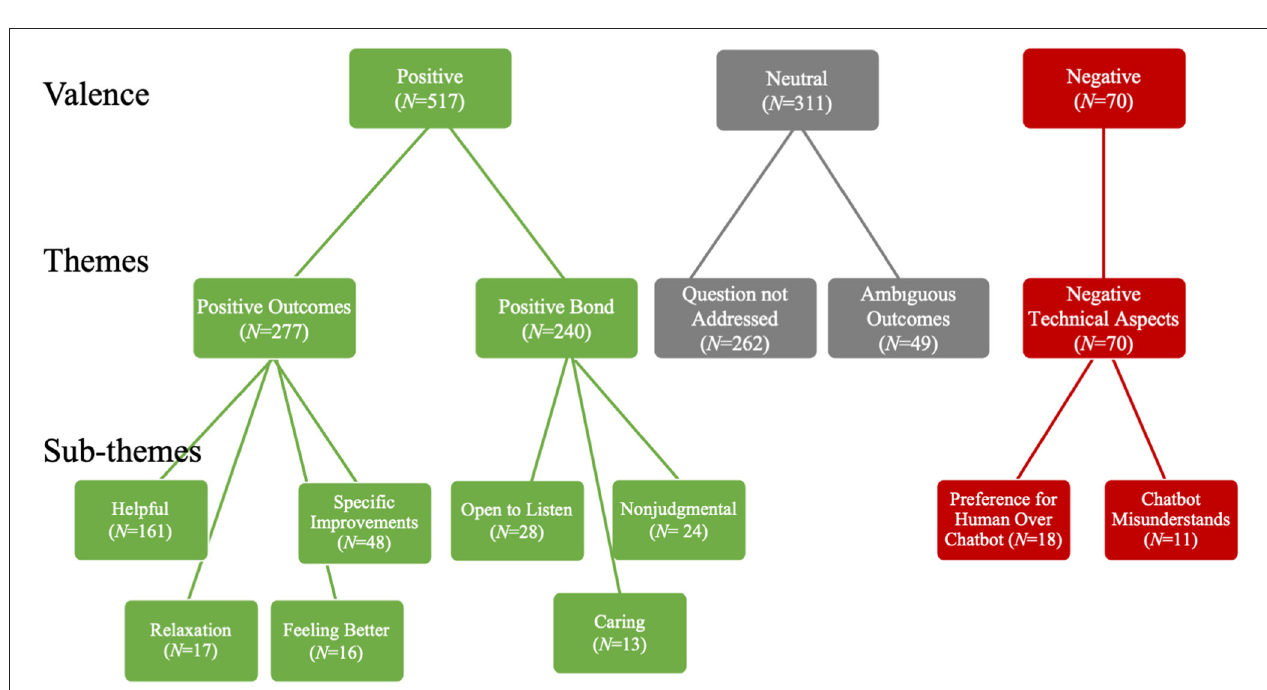
FIGURE 3 | Organization and number of user comments for each valence, theme, and sub-theme.